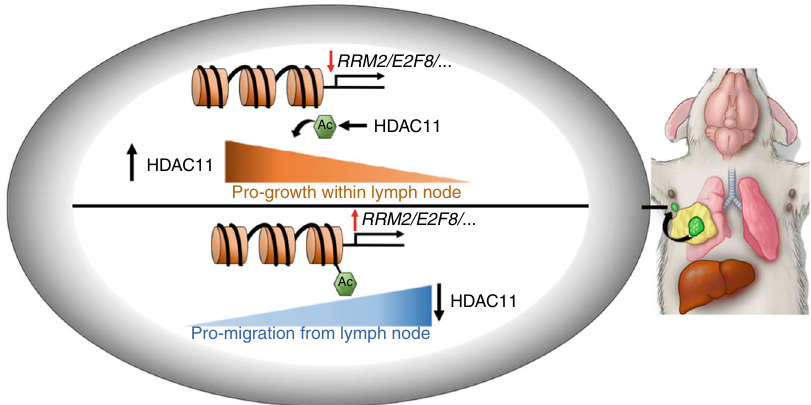
Fig. 6 Graphical abstract of HDAC11 ’ s role in regulating lymph node metastasis. As cancer cells enter the lymph node (top), HDAC11 increases in expression, leading to decreased expression of several transcripts and increased survival within the lymph node. However, as HDAC11 decreases (bottom), the same transcripts increase in expression, leading to an increased migratory phenotype and allowing exit from the lymph node to distant organs. Thus, pharmacologic inhibition of HDAC11 may decrease cancer cell survival within lymph nodes while also increasing their migratory